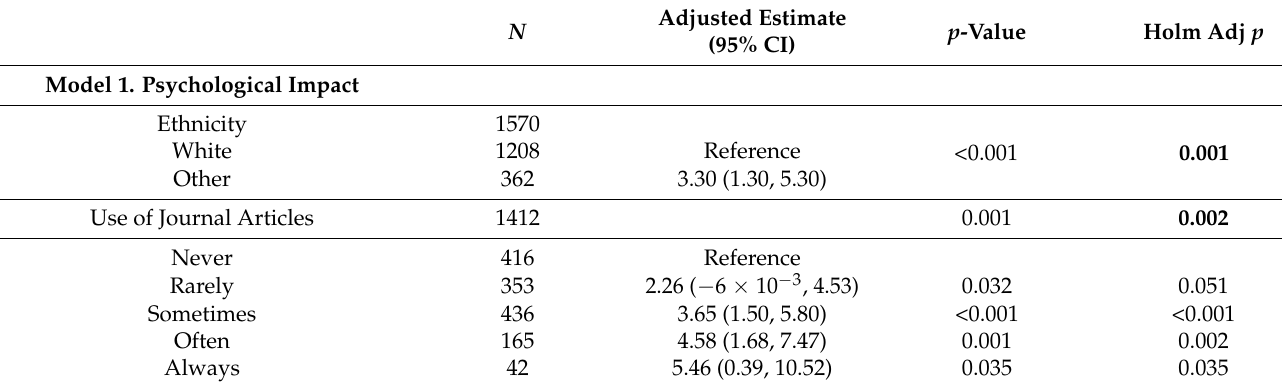
Table 11. Multivariate analysis.